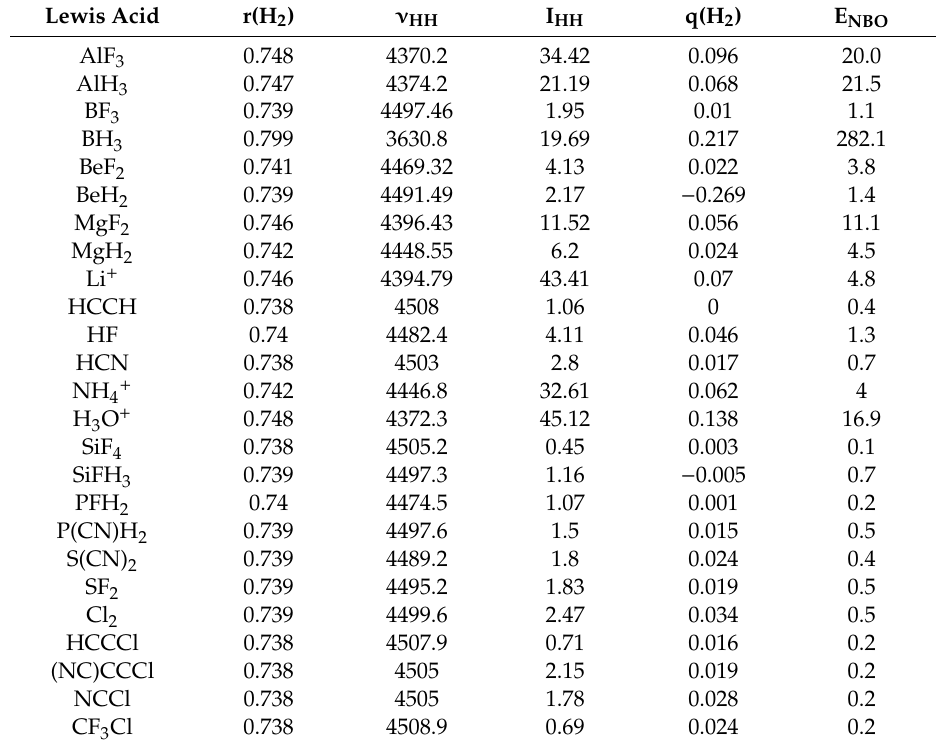
Table 2. The characteristics of complexes analysed, r(H 2 )—the H-H bond length (Å), ν HH —H-H bond stretching frequency (in cm − 1 ), I HH —intensity of the H-H stretching mode (km mol − 1 ), q(H 2 )—the charge of dihydrogen in the complex (in au), and E NBO —the energy of the most important orbital–orbital interaction in the complex considered (in kcal / mol). *